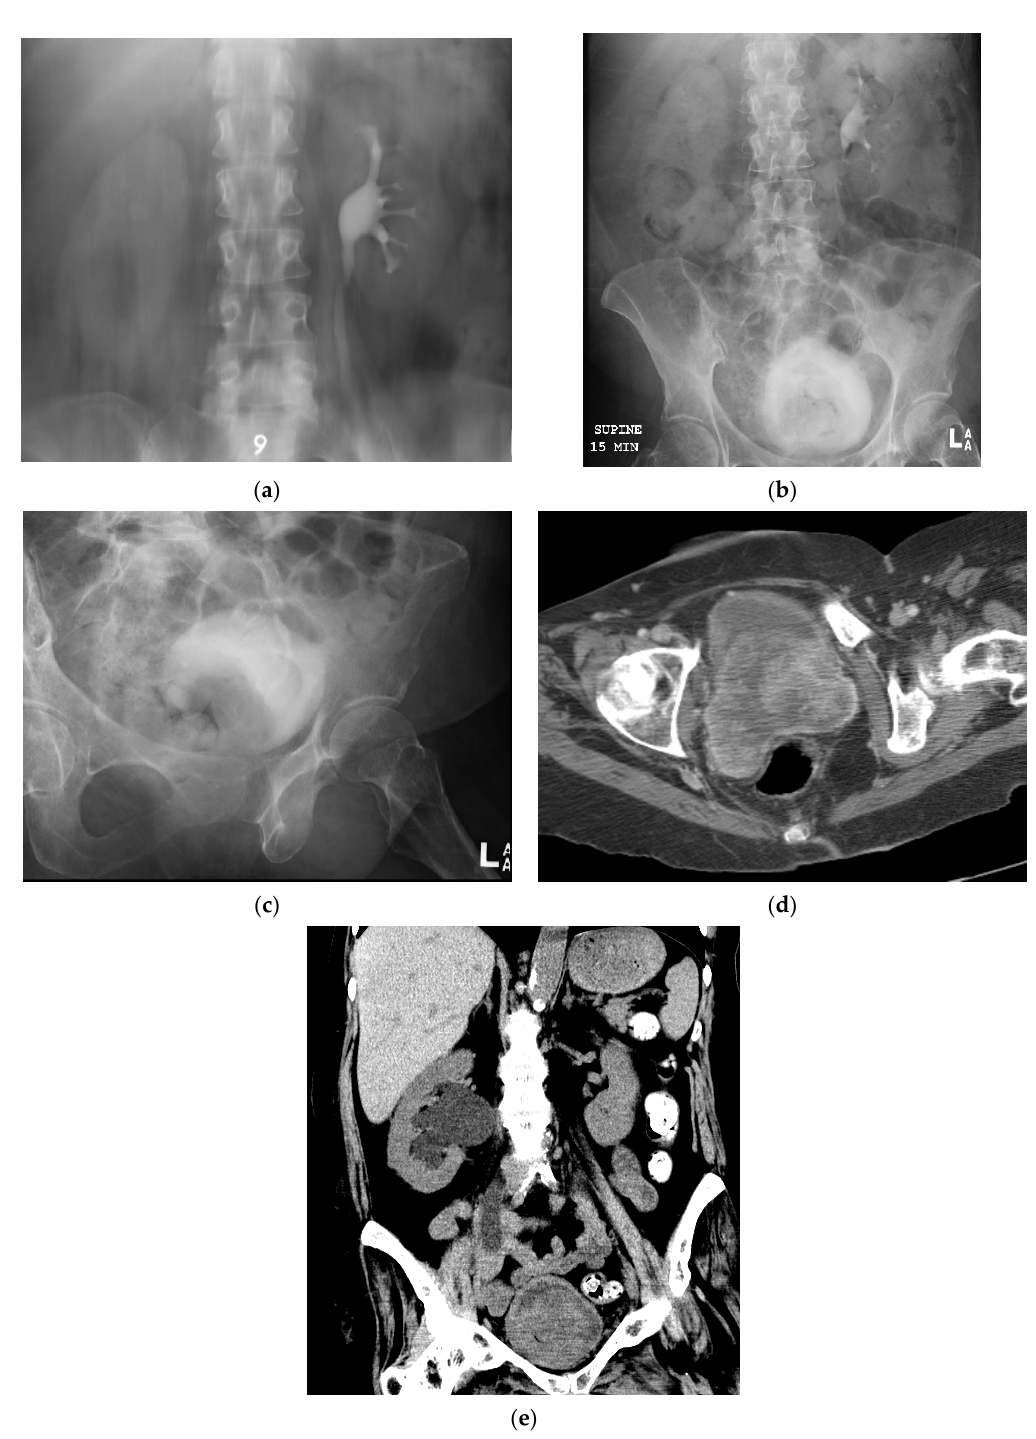
Figure 9. IVP and CT images of locally advanced bladder cancer . ( a ) IVP image of the upper urinary tract at 9-min is without filling defect in the left collecting system to suggest left-sided upper tract disease. The right collecting system is poorly opacified secondary to hydroureteronephrosis, better depicted on CT. ( b ) IVP image at 15 min shows a large filling defect in the bladder. ( c ) Magnified oblique view of the bladder better show a posterior filling defect. ( d ) Axial portal